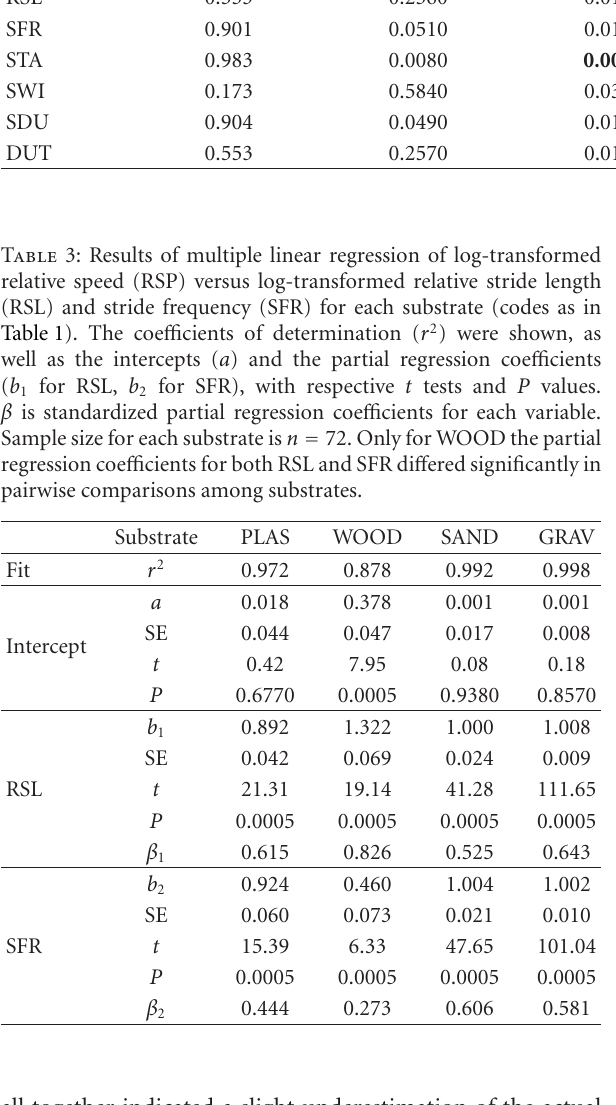
Table 2: Results of linear regression between the logarithm of means of nine kinematic variables and the logarithm of roughness for four substrates (codes as in Table 1). Coe ffi cients of determination r 2 and their associated probabilities P are presented. Sample size is n = 4 for each linear regression. Absolute residuals of these linear regressions for each substrate are also shown, with small values ( < 0.01) in bold. Absolute residuals Variable r 2 P PLAS WOOD